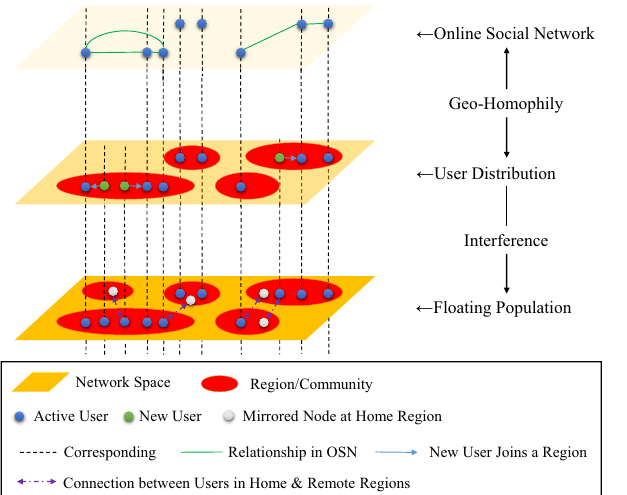
Figure 1. A three-layered analytical framework that de fi nes the geo- homophily of OSNs to map the OSN message